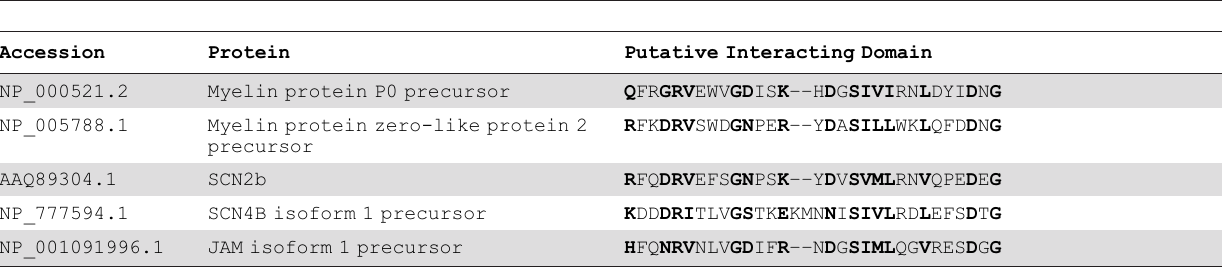
Table 1. BLASTP and Alignment of the amino acid sequence of beta-2 ( SCN2B ) show several proteins having highly conserved domains within their sequence.